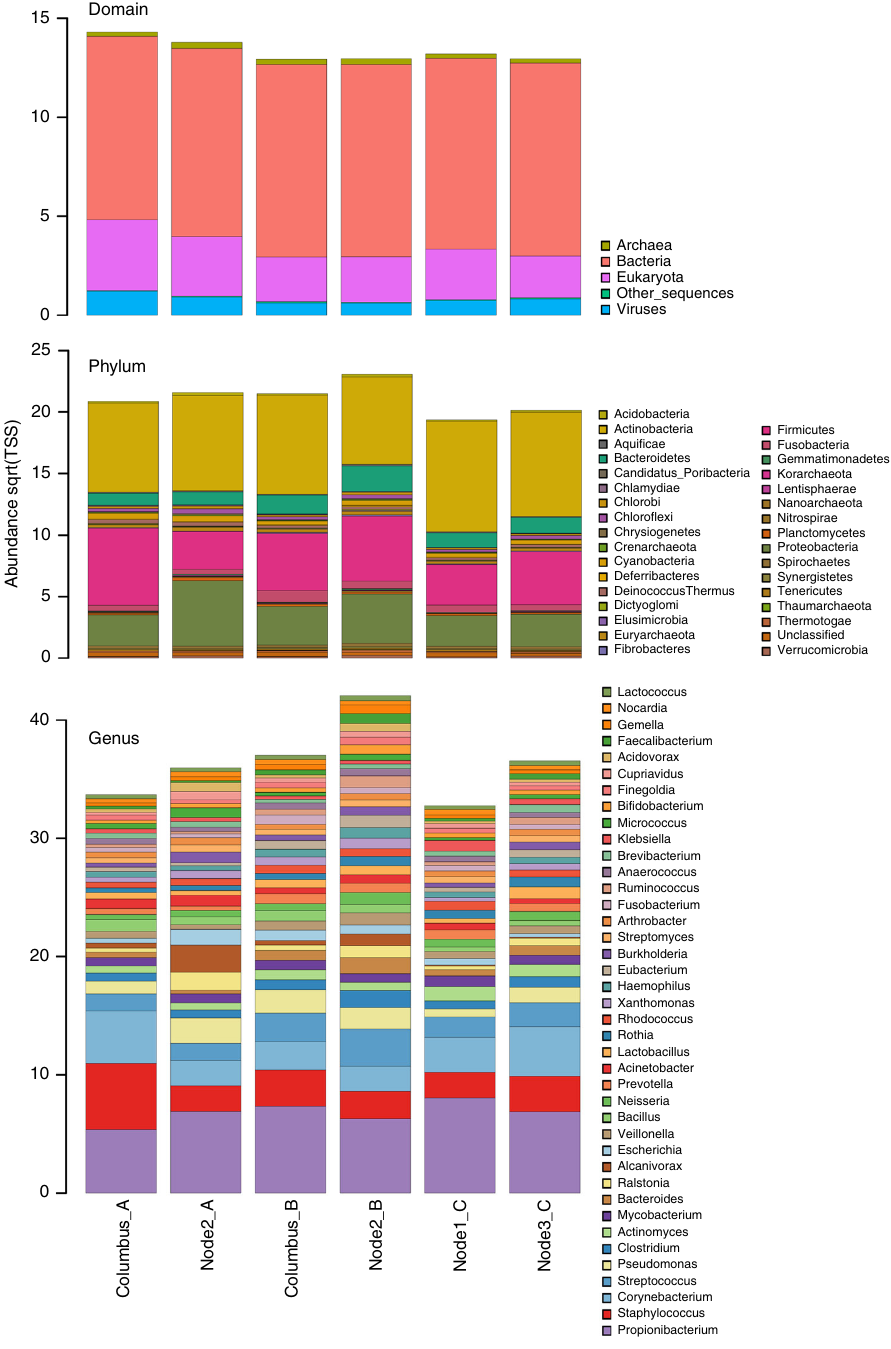
Fig. 4 Shotgun metagenome-based taxonomic information from ISS locations. Information is given at domain, phylum and genus (top 40) level. Columbus_A refers to metagenomics information retrieved from Columbus module, session